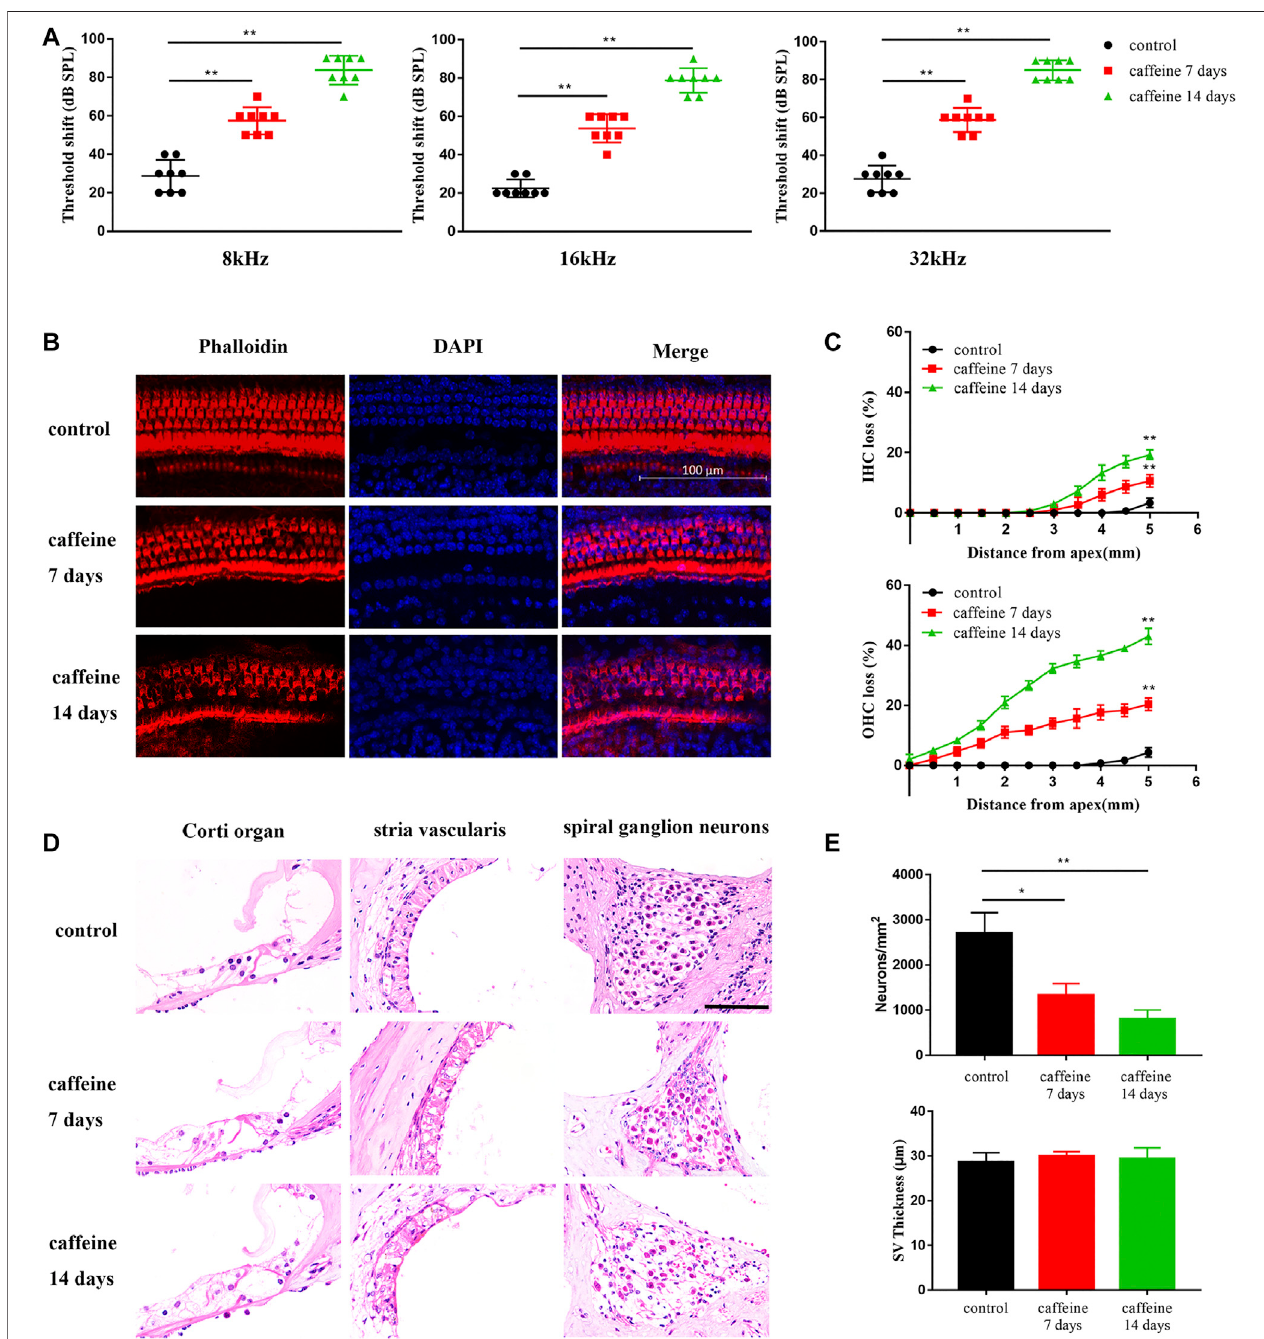
FIGURE 1 | Caffeine destroys cochlear hair cells, stria vascularis, and spiral ganglion neurons in C57BL/6 mice. (A) ABR threshold shifts measured in C57BL/6 micetreatedwith120 mg/kgcaffeinefor7or14 days.Thecontrolmice weretreatedwiththesame volume ofnormalsaline. Dataarepresentedasindividualpointsand means ± SD, **p < 0.01 . (B) Imagesofmiddle membrane stainedwithphalloidin (red).DAPI (blue) wasused to stainthe nuclei.Scale bar: 100 μ m. (C) Haircell counts in C57BL/6mice treatedwith120 mg/kgcaffeineat 7and 14 daysand controlmice treatedwith normal saline. N (cid:1) 3in each group. Dataarepresented asindividual points andmeans ± SD, **p < 0.01 . (D) Images ofCortiorgan, spiralganglionneuron,andstriavascularisstainedwithHE.Scalebar:100 μ m. (E) Spiralganglionneuron counts at the middle cochlear turn in each group. N (cid:1) 3 in each group. Data are presented as individual points and means ± SD, **p < 0.01, *p < 0.05 .